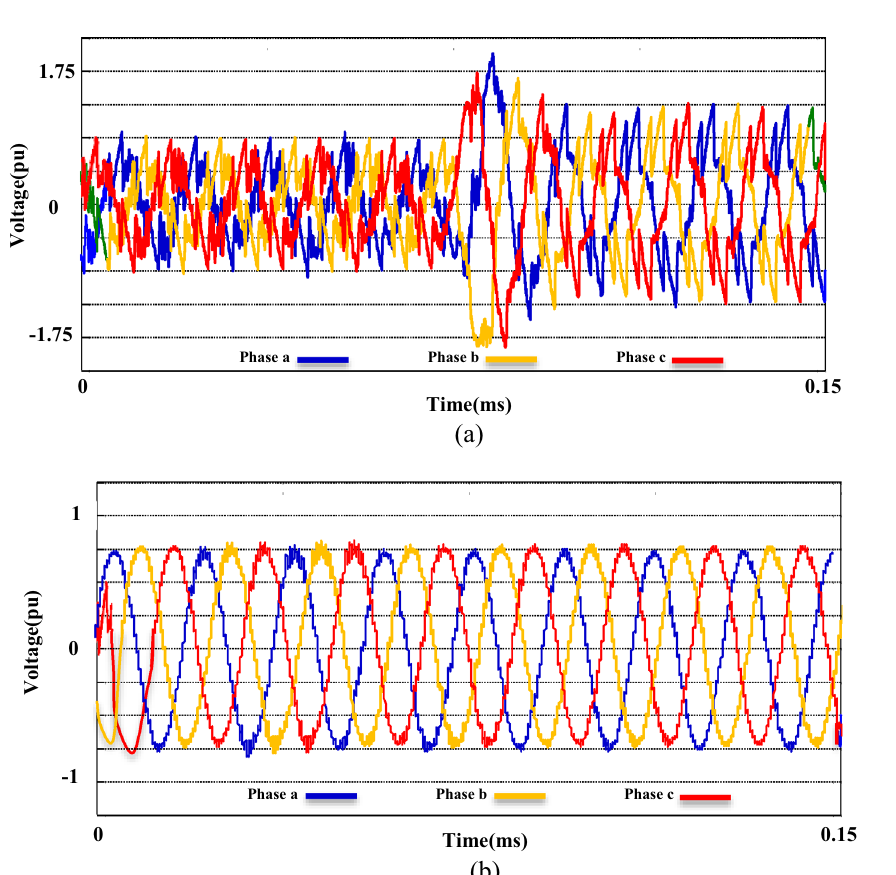
Figure 14. Three phase voltage extreme disturbances; ( a ) without the M-UPQC module, ( b ) with the M-UPQC